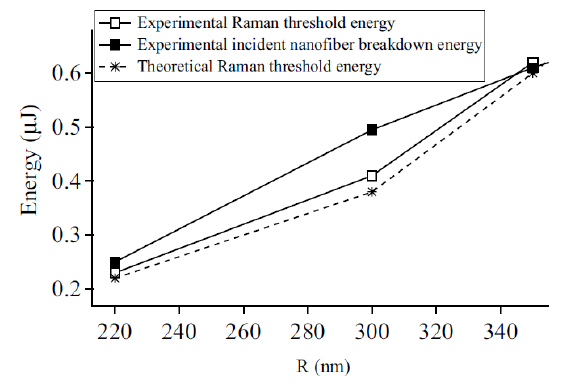
Fig. 3. Operating range of the Raman converters.